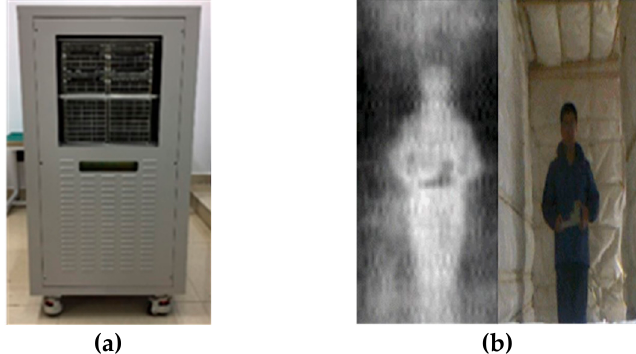
Figure 3. ( a ) A 256-channel demonstrator employing the hybrid architecture; ( b ) An image of a person holding a metallic gun model under an artificial hot background with a temperature of about 573 Kelvin.